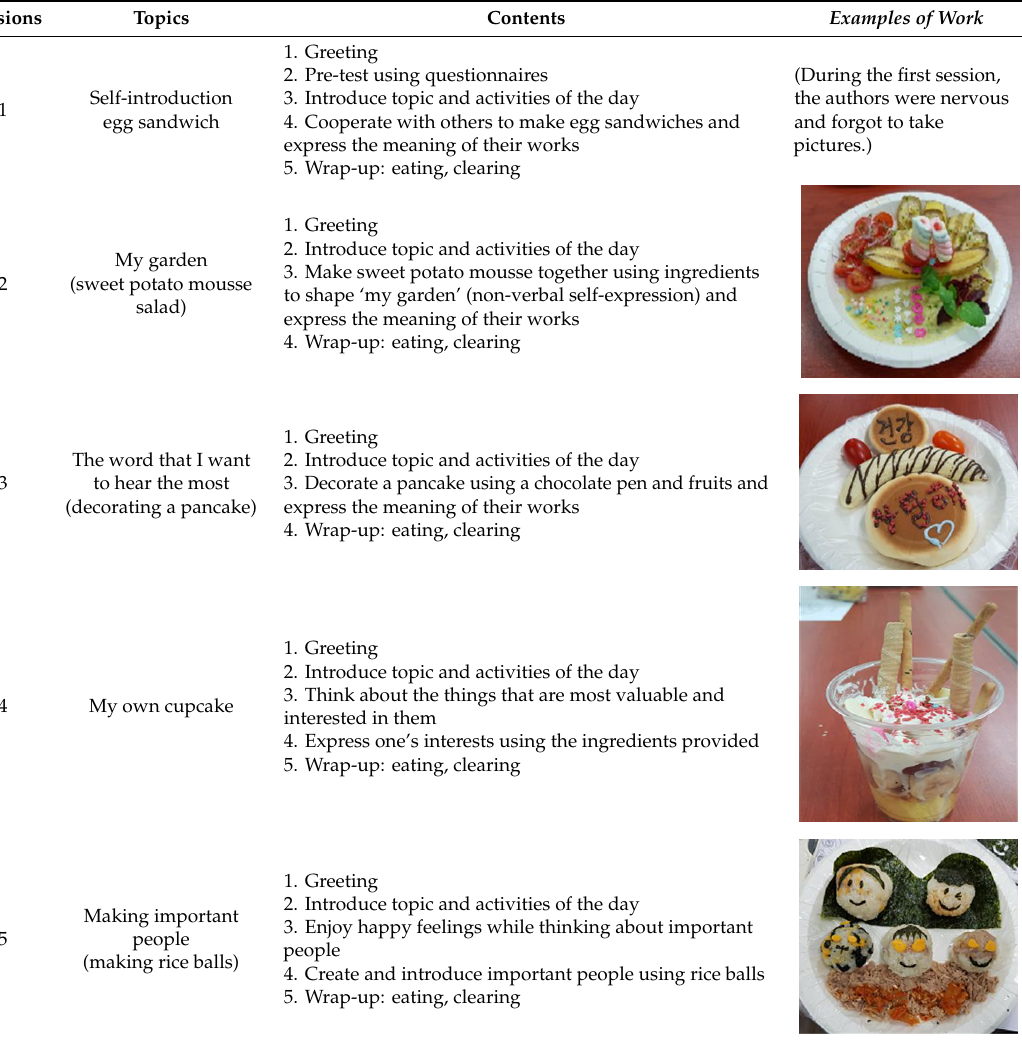
Table 1. Overview of eight sessions of food art therapy and examples of the work of participants.